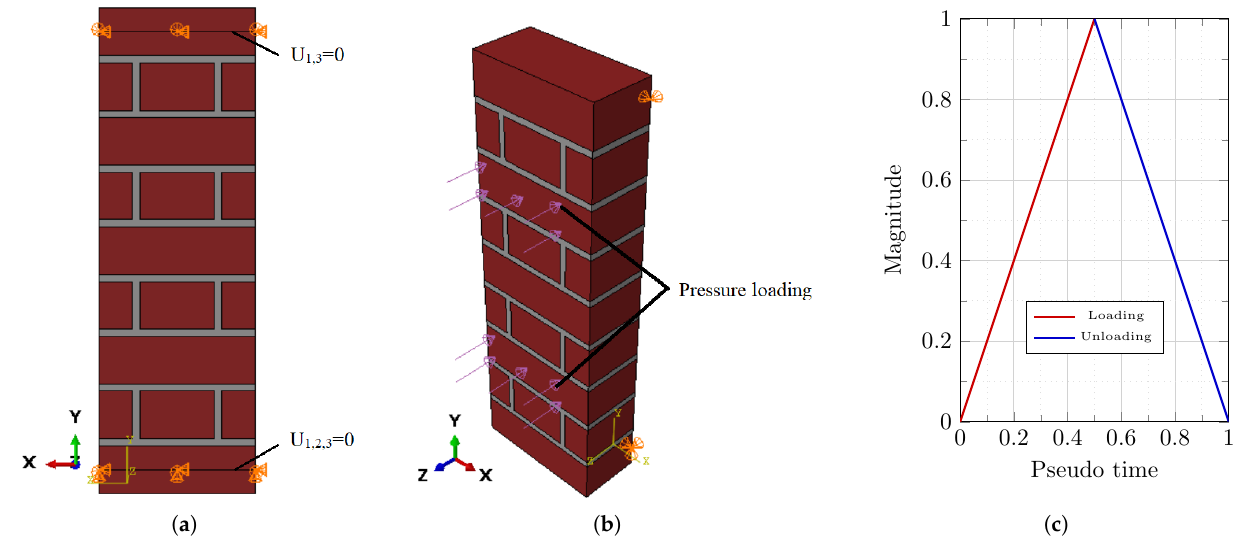
Figure 5. Boundary conditions in the masonry prism: ( a ) boundary condition details; ( b ) out-of-plane load application; ( c ) the amplitude of applied out-of-plane